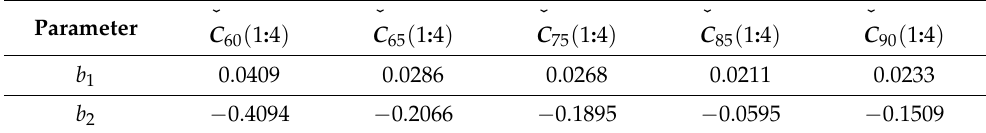
( 1 : 4 ) parameters’ values (procedure 6). 1